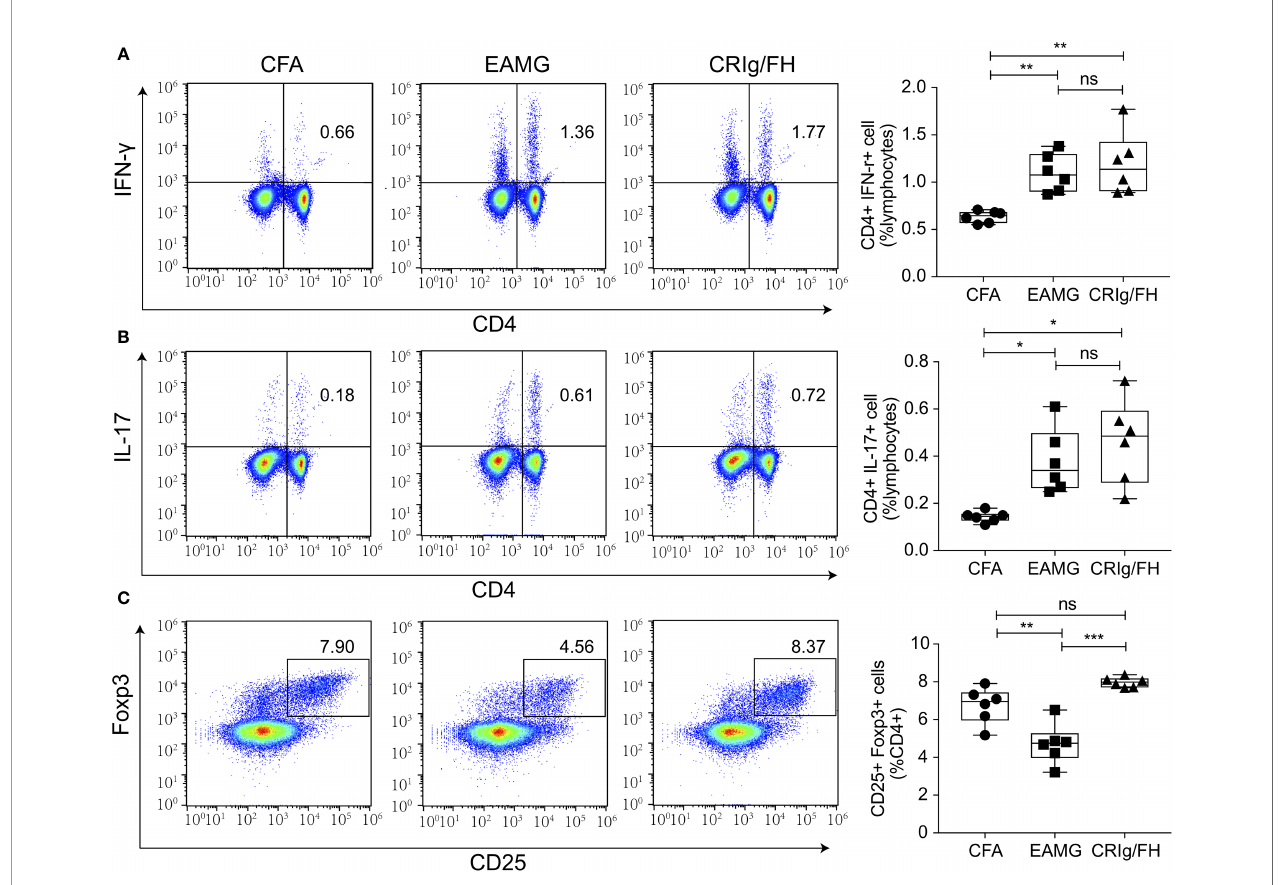
FIGURE 5 | CRIg/FH treatment upregulates Treg subset in active EAMG rats. (A – C) The levels of Th1 (A) , Th17 (B) , and Treg (C) in the spleen. Expression levels of Th1 (CD4 + IFN- g + ), Th17 (CD4 + IL-17 + ), and Treg (CD4 + CD25 + Foxp3 + ) cells were determined by fl ow cytometry. Data are expressed as mean ± SD; n = 6/group; ns, not signi fi cant, * p < 0.05, ** p < 0.01, *** p < 0.001; one-way ANOVA test with Tukey ’ s multiple comparison